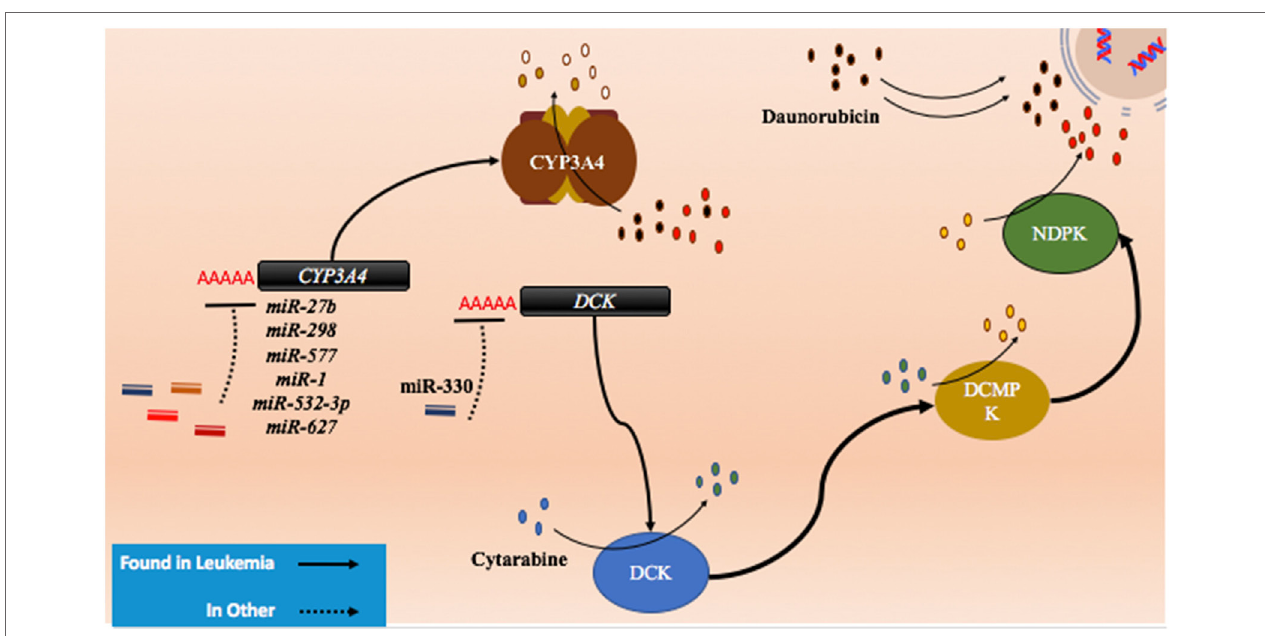
FigURe 5 | The role of metabolism and microRNA (miRNA) in daunorubicin and cytarabine treatment. While daunorubicin is an active drug, cytosine requires bio-activation. As a cytosine analog, it must undergo three phosphorylation steps to become fully activated and capable of incorporating into the genome. The deactivation of daunorubicin and cytarabine is partially dependent on the cytochrome P450s and they commonly share CYP3A4 in their pathway of degradation. In other cancer, CYP3A4 has been shown to be targeted by miR-27b, miR-298, miR-577, miR-1, miR-532-3p, and miR-627. In the pathway of cytarabine activation, deoxycytidine kinase (DCK) has been shown to be downregulated by miR-330 in other